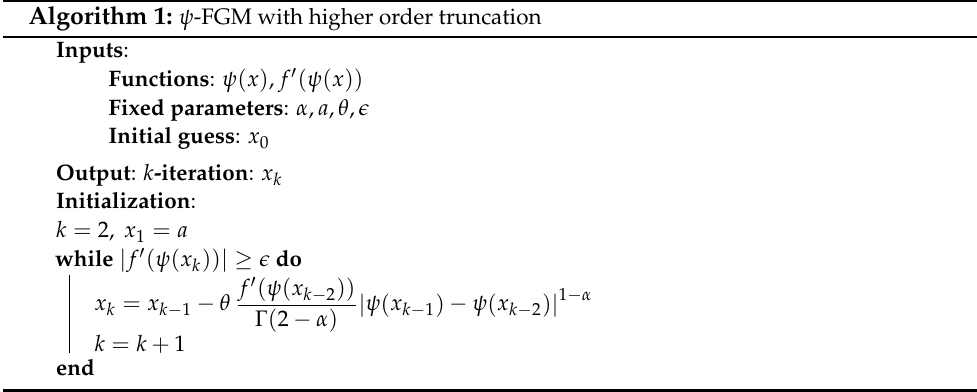
Algorithm 1: ψ -FGM with higher order